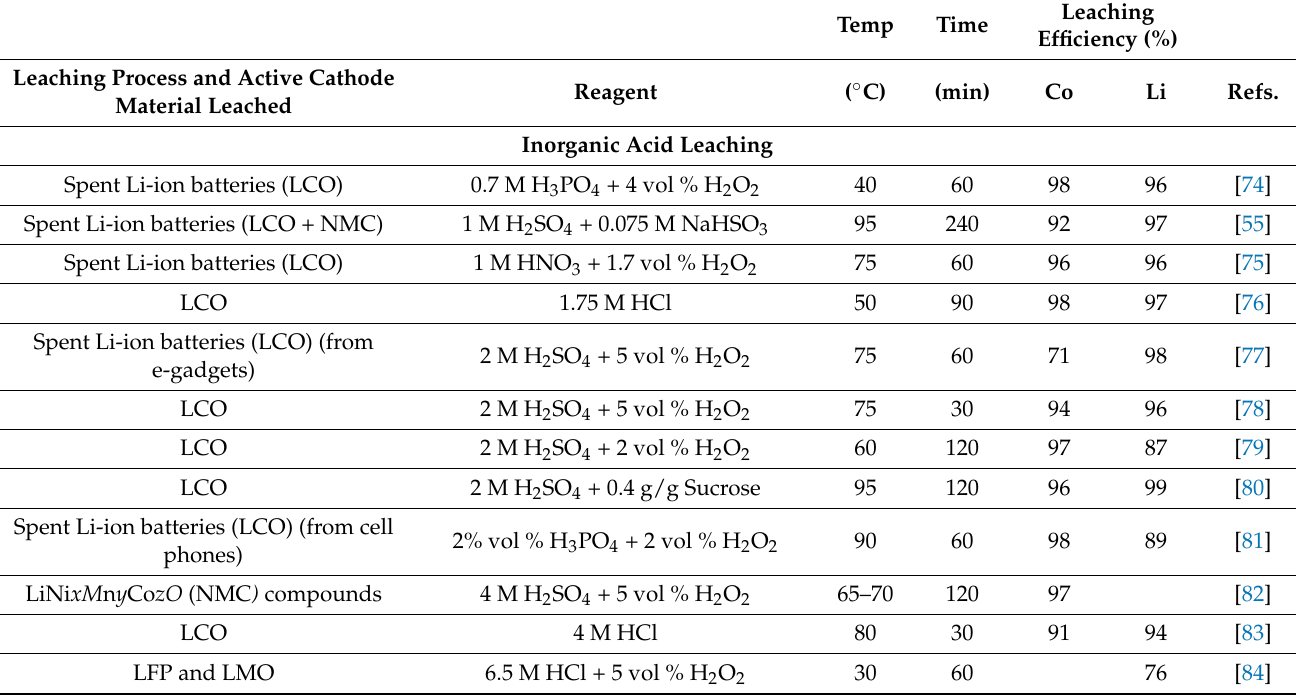
Table 3. Summative review of leaching spent Li-ion batteries using different leaching reagents. Leaching Temp Time Efficiency (%) Reagent ( ◦ C) (min) Li Refs. Inorganic Acid